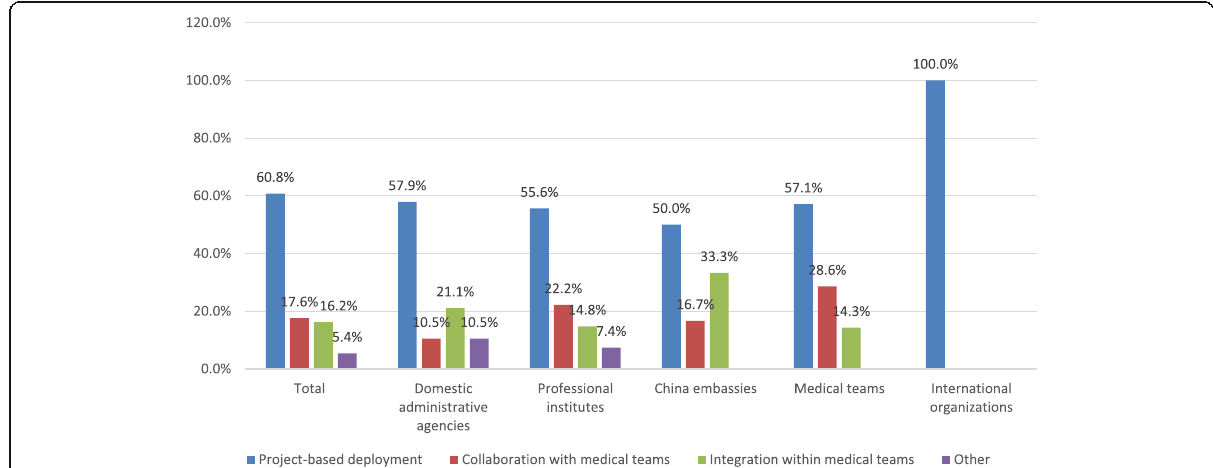
Fig. 3 Deployment modes* of Chinese global health workforce according to five different organizations. * Three alternative modes of deployment of Chinese global health workforce. Project-based deployment refers to independently aligning with the global health workforce with project needs. Collaboration with medical teams refers to working closely with medical teams. Integration within medical teams refers to deploying the global health workforce as members of medical